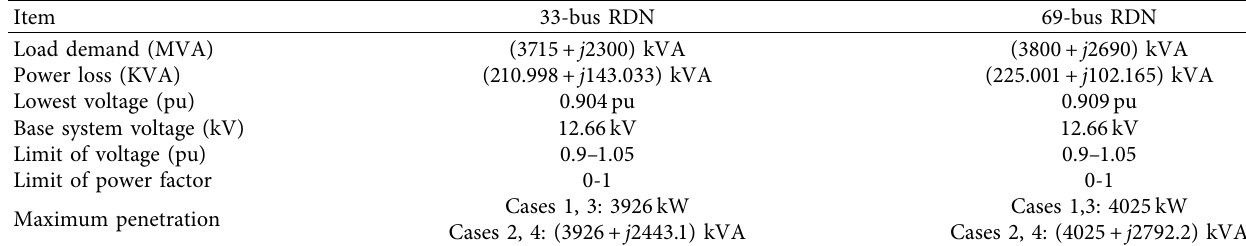
Table 1: Data test networks and constraints.